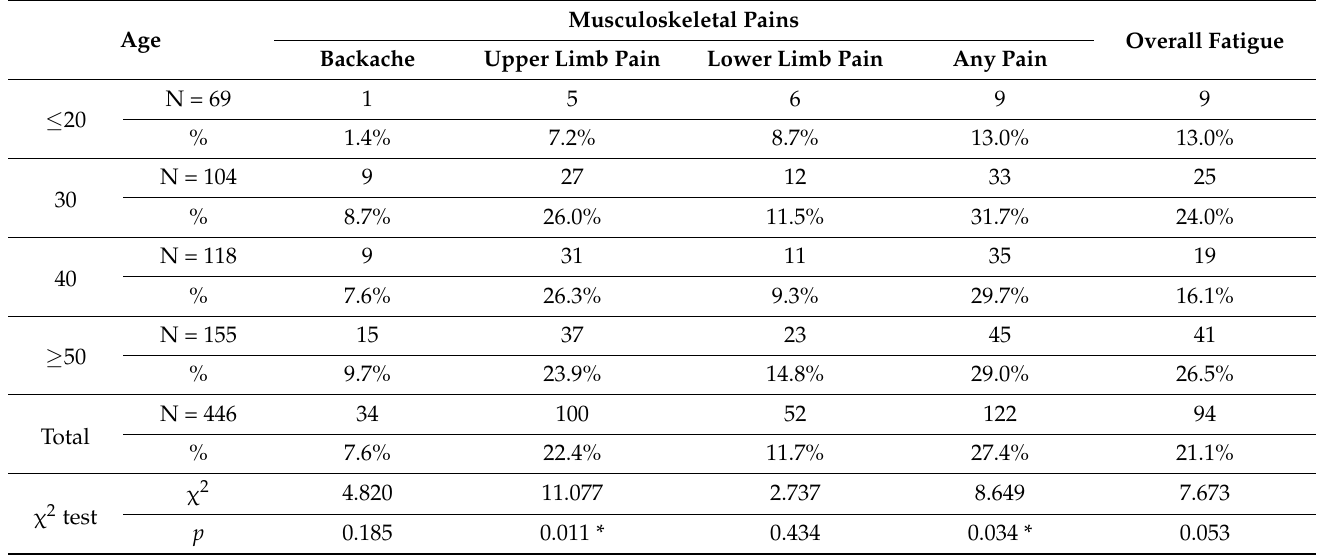
Table 3. Distribution of subjective musculoskeletal pains and overall fatigue by age group.